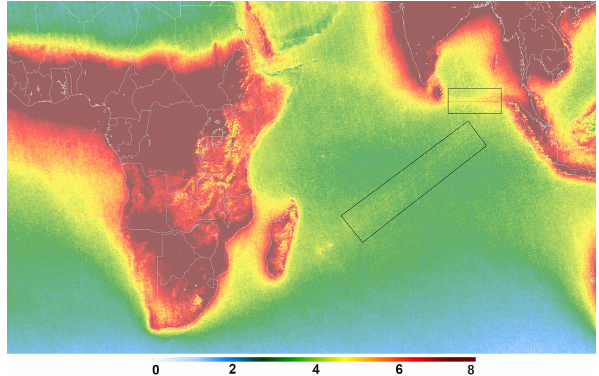
Figure 18. Seasonal DJF map of TROPOMI HCHO tropo- spheric columns between December 2018 and February 2021, on a spatial grid of 0.05 ◦ in latitude and longitude. Observations are only filtered using the provided qa_values > 0.5 (max scale: 8 × 10 15 molec.cm − 2